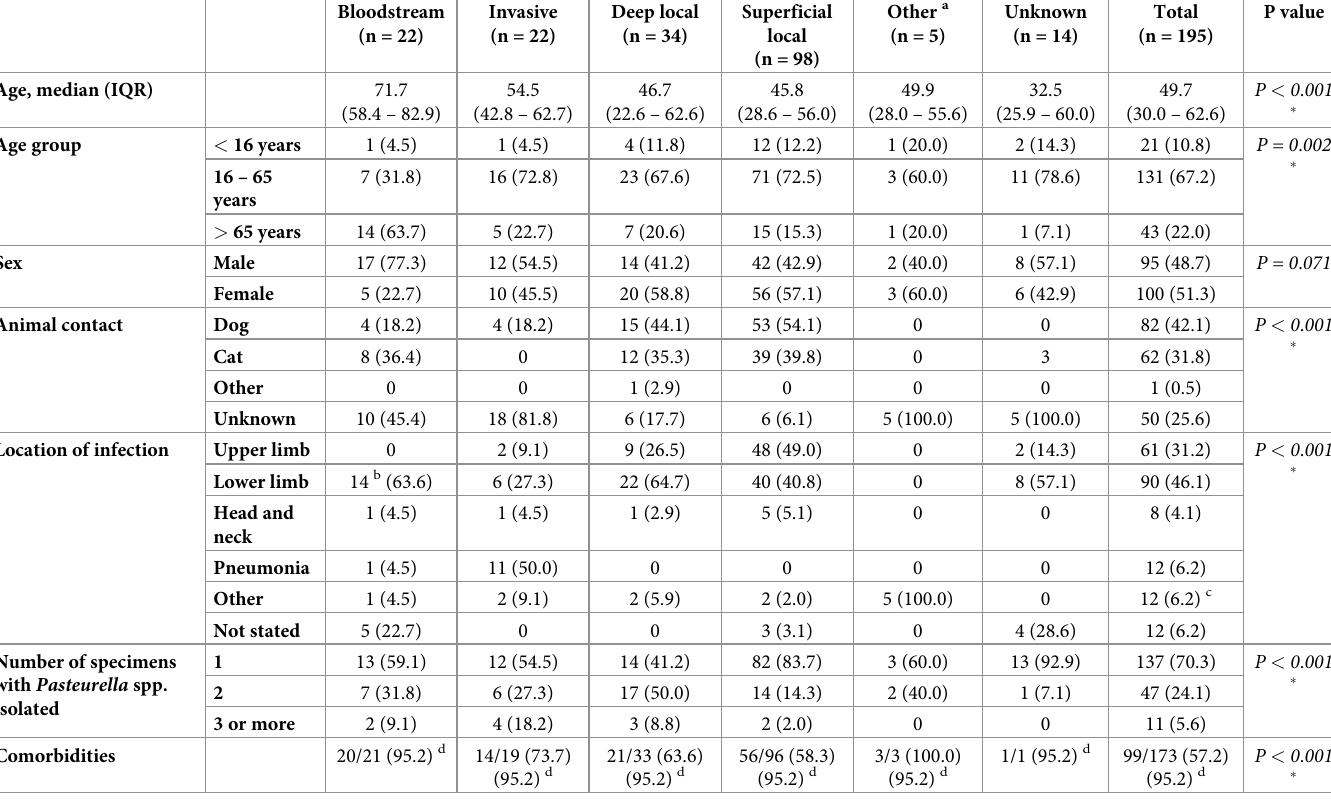
Table 2. Clinical characteristics of patients with Pasteurella spp. infections in the Top End from